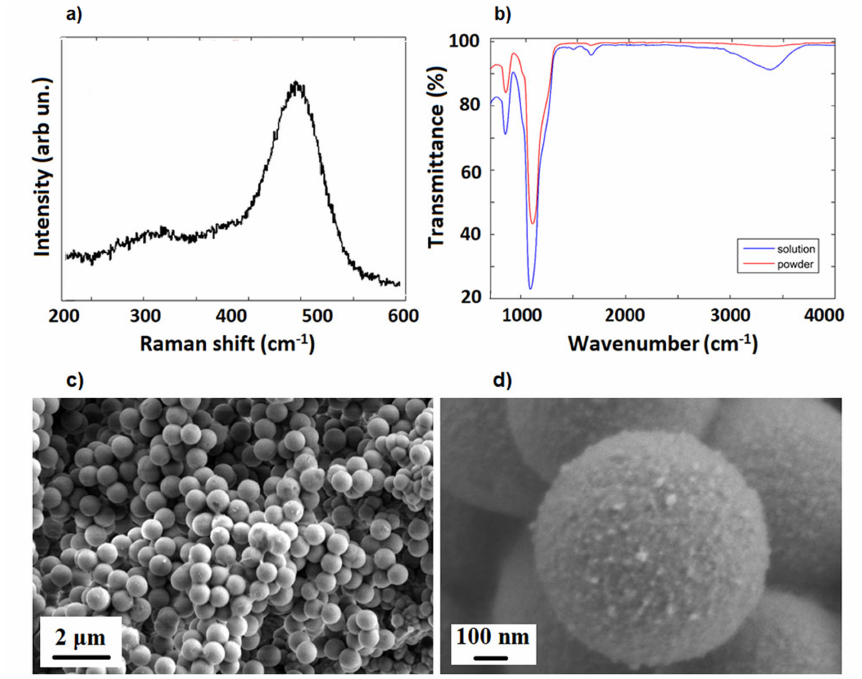
Figure 1. Raman ( a ), FTIR ( b ) and SEM images ( c , d ) of SiO 2 template microparticles.